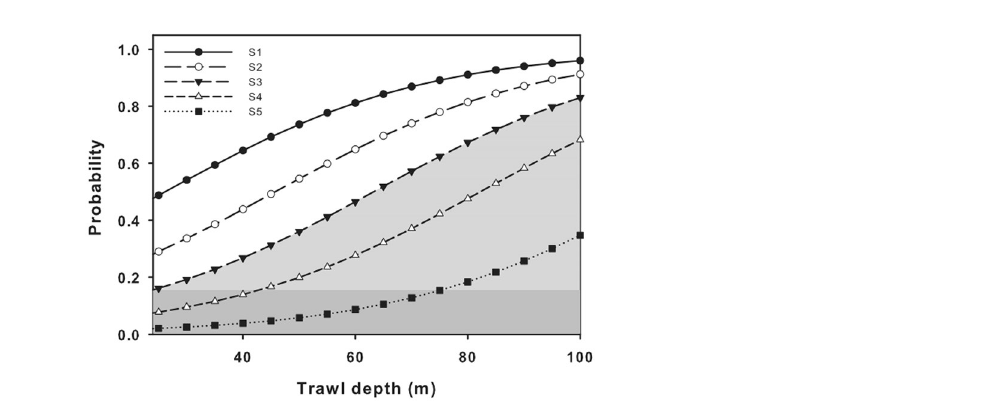
Figure 2. Model fit of the probability of gas emboli [P(GE)] by depth ( ± s.d) of gear deployment for turtles bycaught in ( A ) trawls and ( B ) gillnets. Number above symbol is number of animals in each bin.